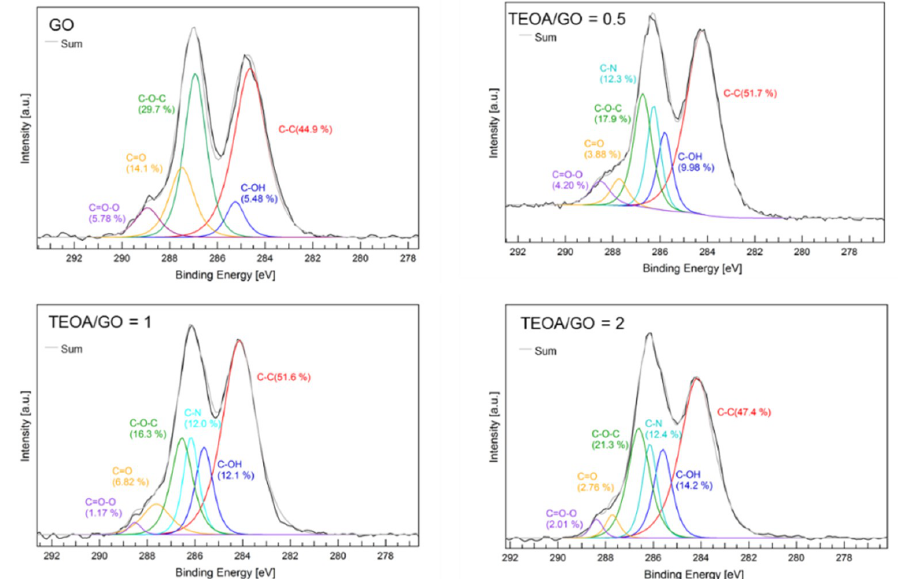
Figure 5. C 1s XPS spectra of a GO membrane and GO-TEOA membranes fabricated with different TEOA/GO.